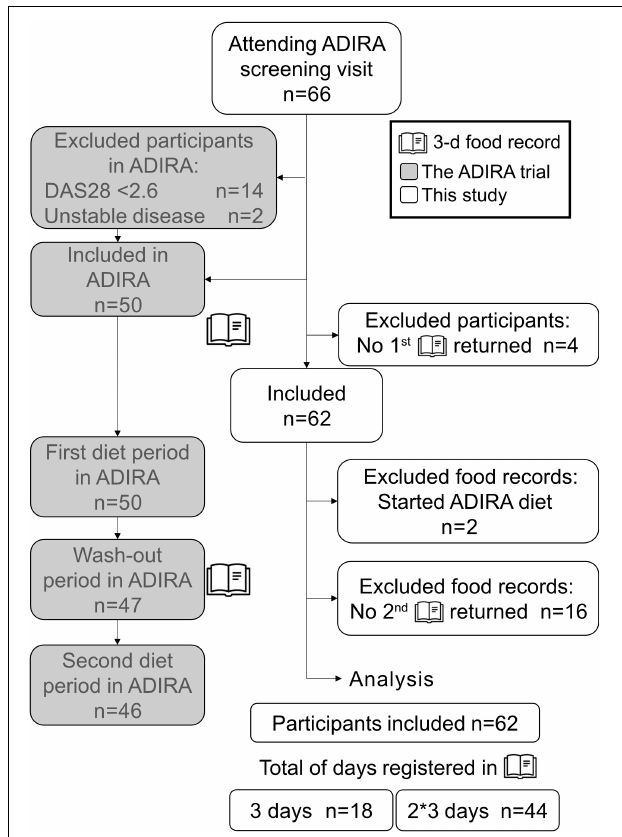
FIGURE 1 | Flowchart showing inclusion of study participants. The gray boxes represent the ADIRA trial, and the white boxes represent this study. ADIRA, anti-inflammatory diet in rheumatoid arthritis; DAS28, disease activity